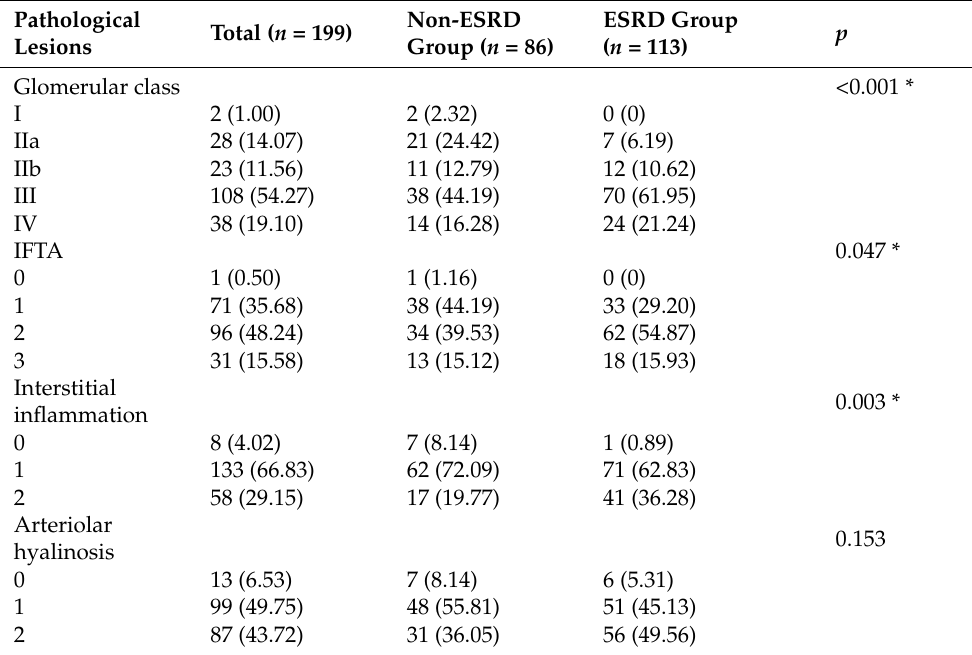
Table 2. Baseline pathological findings in ESRD and non-ESRD groups.